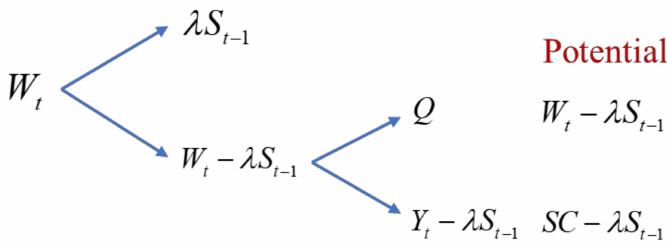
Figure 1. The partitioning of the total available